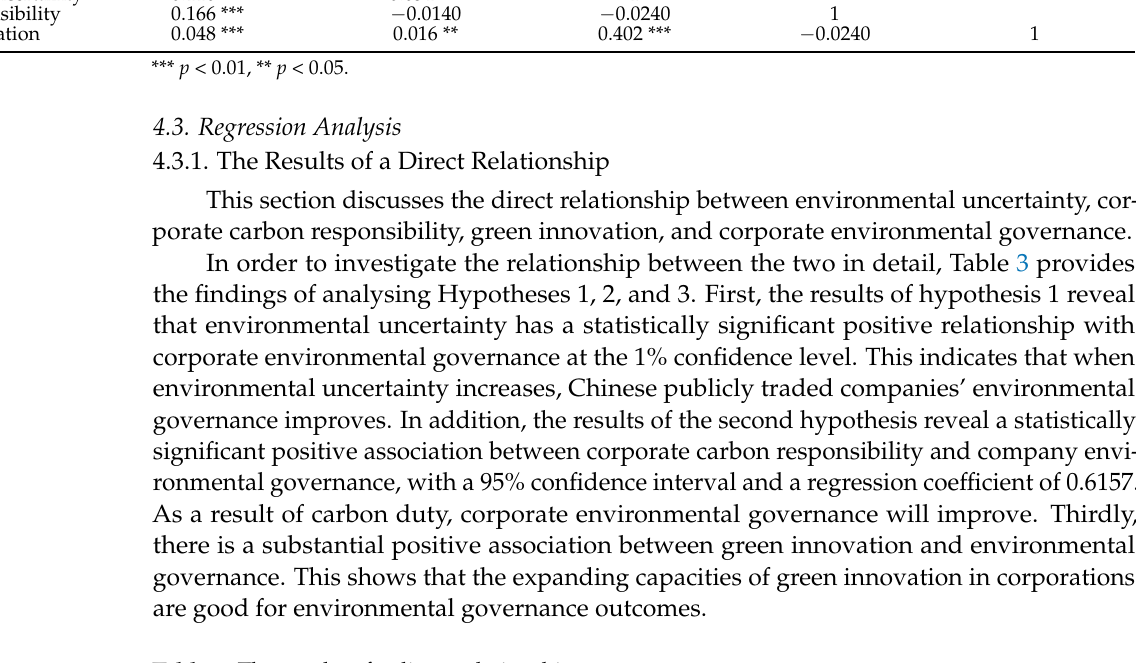
Table 3. The results of a direct